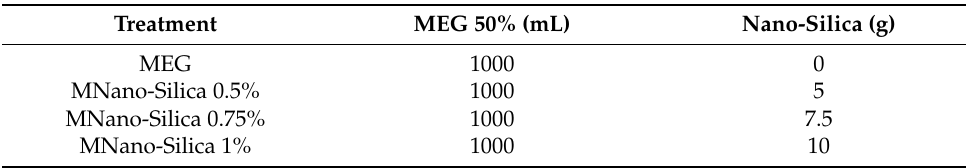
Table 1. The volume of MEG and nano-silica as impregnation solutions. Treatment MEG 50%